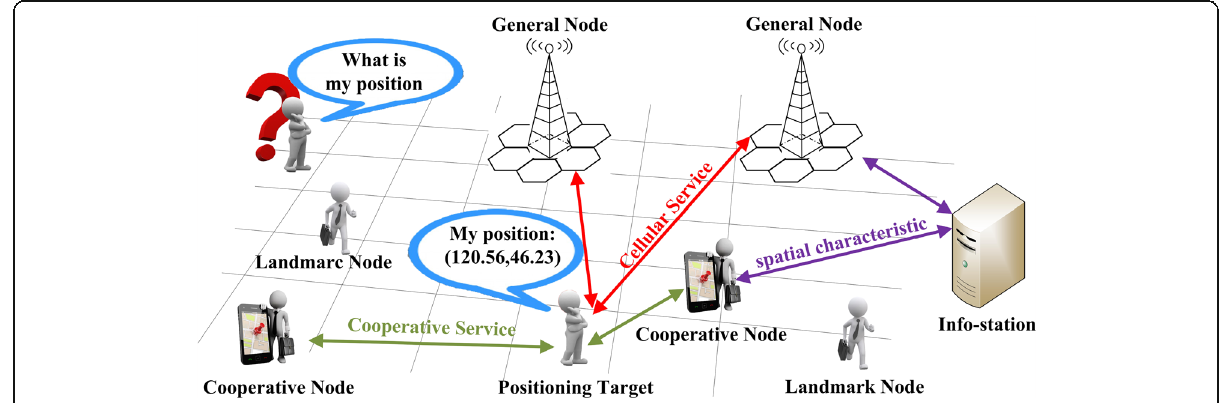
Fig. 1 The components of a typical cellular-based cooperative localization